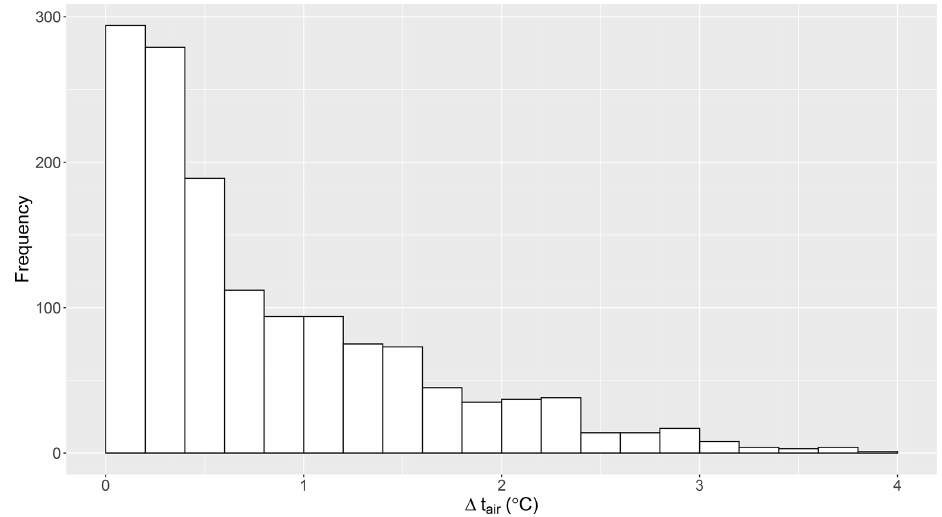
Figure 10. Frequency of temperature differences, (cid:49)t air , considering all pairs of instruments, of the records exceeding the selected threshold for reflected short-wave radiation of 200Wm − 2